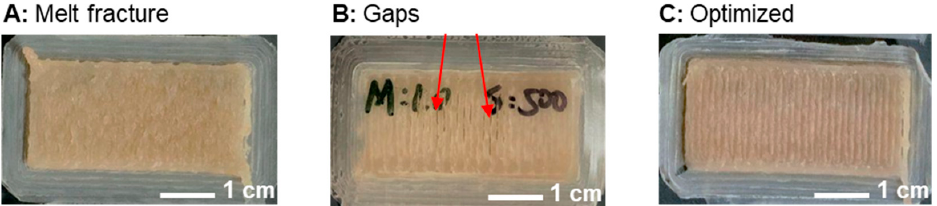
Figure 7. Print speed and multiplier optimization for HDPE-V to reduce melt fracture. ( A ) Speed: 800 mm/min; multiplier: 1×. ( B ) Speed: 500 mm/min; multiplier: 1×. ( C ) Speed: 500 mm/min; multiplier: 1.2×.